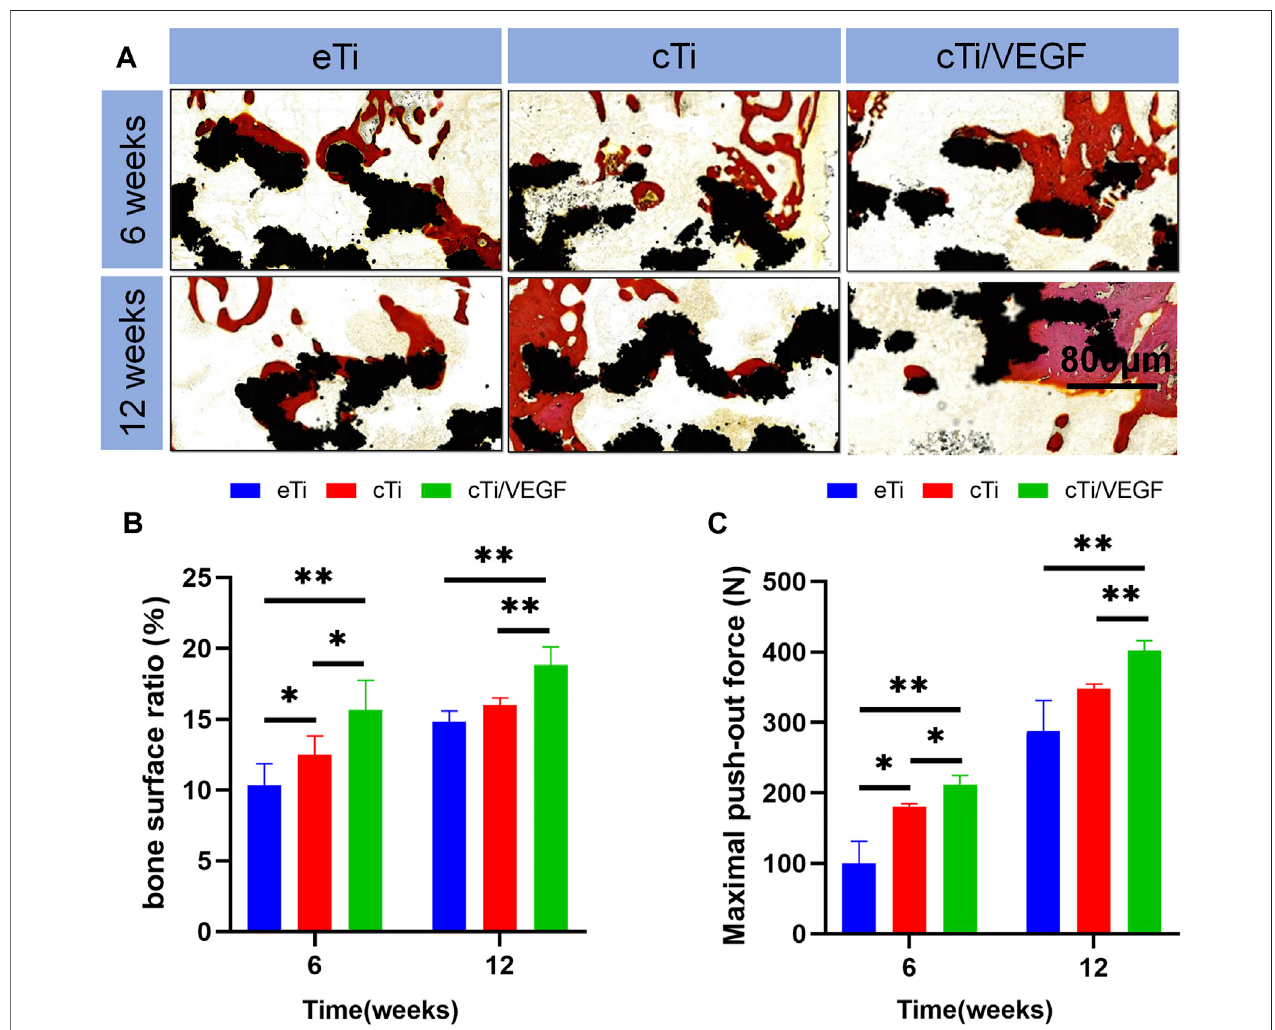
FIGURE 6 | (A) The eTi, cTi, and cTi/VEGF scaffolds were separately implanted into rabbit femoral epicondyles and allowed to remain for 6 and 12 weeks. Subsequently, hard sections were prepared and stained with VG (black: Ti6Al4V scaffold; red: new bone) (B) the proportion of new bone area to scaffolds pores (C) maximum load in the detaching test of eTi, cTi, and cTi/VEGF after implantation into rabbit femoral epicondyles for 6 and 12 weeks (n (cid:1) 3).